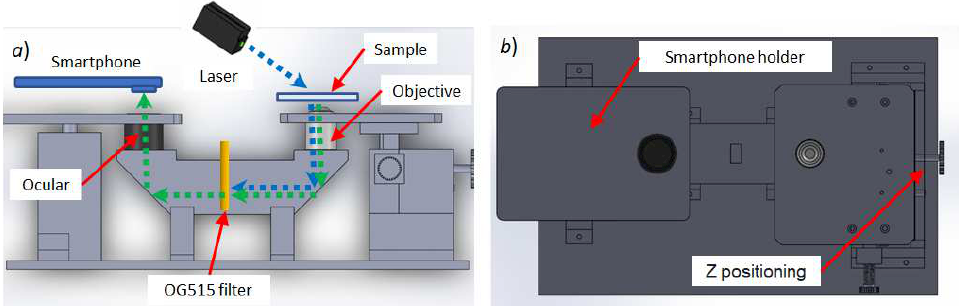
Figure 4. Three-dimensionally printed designed scheme. ( a ) Side view design showing the simplified longpass filtering system, and ( b ) top view design, where the smartphone is positioned, and the Z-positioning gear.